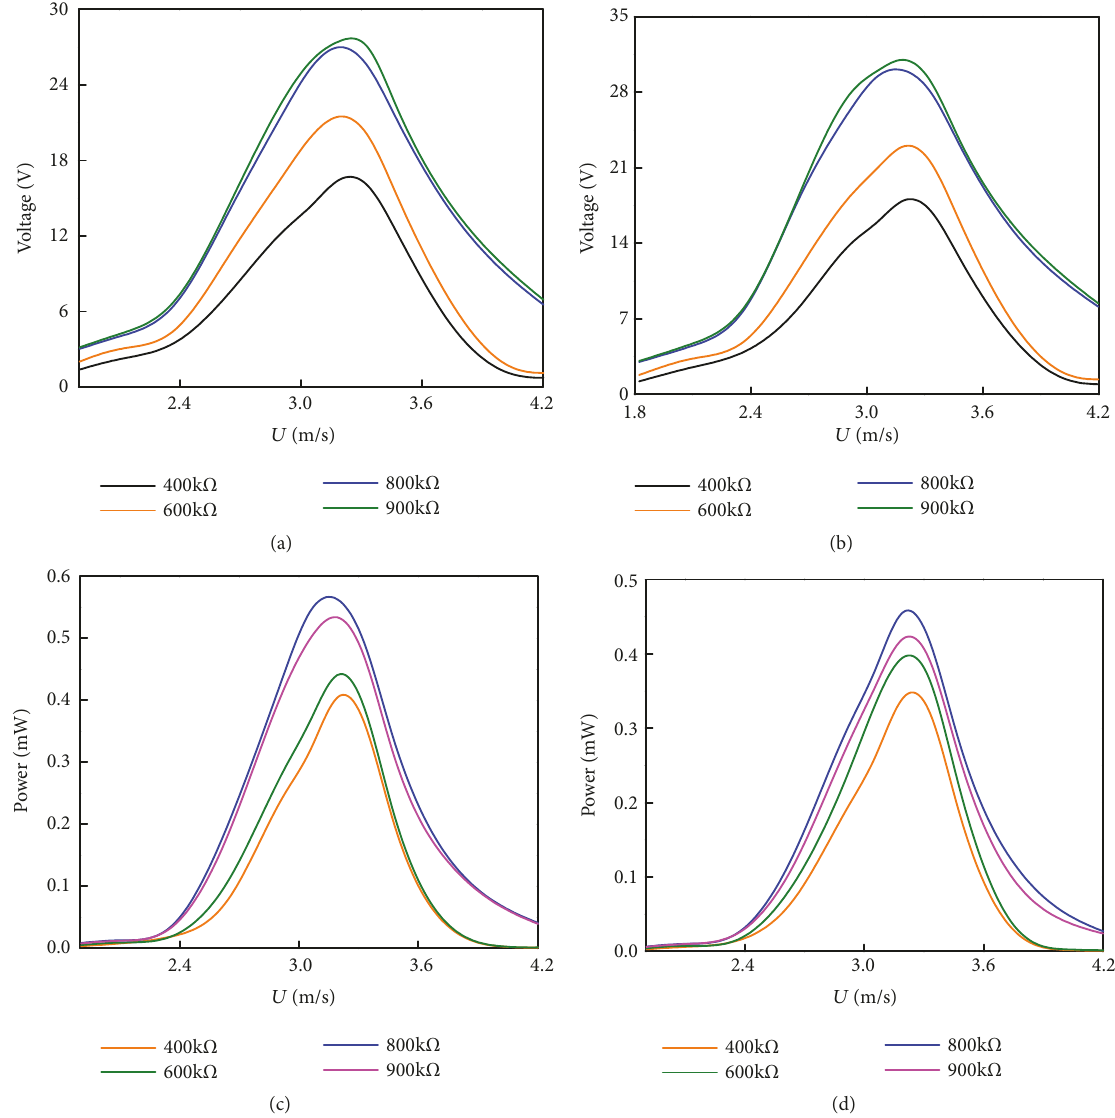
Figure 10: Comparison of voltage and power response between smooth cylinder and hemisphereprotrusion structure:(a) voltage response of smooth cylinder; (b) voltage response of hemisphere; (c) power response of hemisphere protrusion structure; (d) power response of smooth cylinder